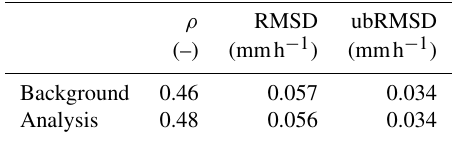
Table 5. Time–space average values of background and analysis performances of evapotranspiration predictions (comparison with in situ observed